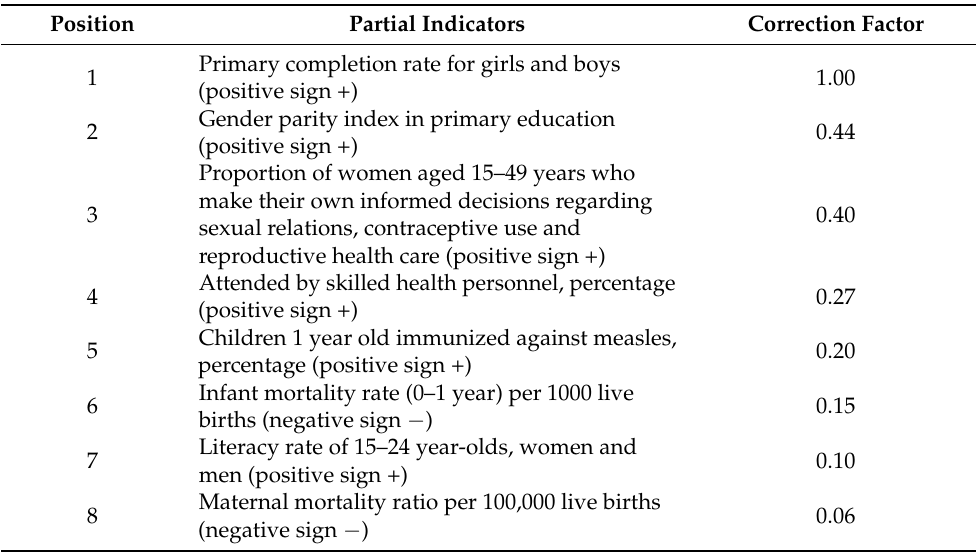
Table 2. Order of partial indicators of SDG3 according to correction factor and sign of variables’ relationship to increase in Good Health and Wellbeing